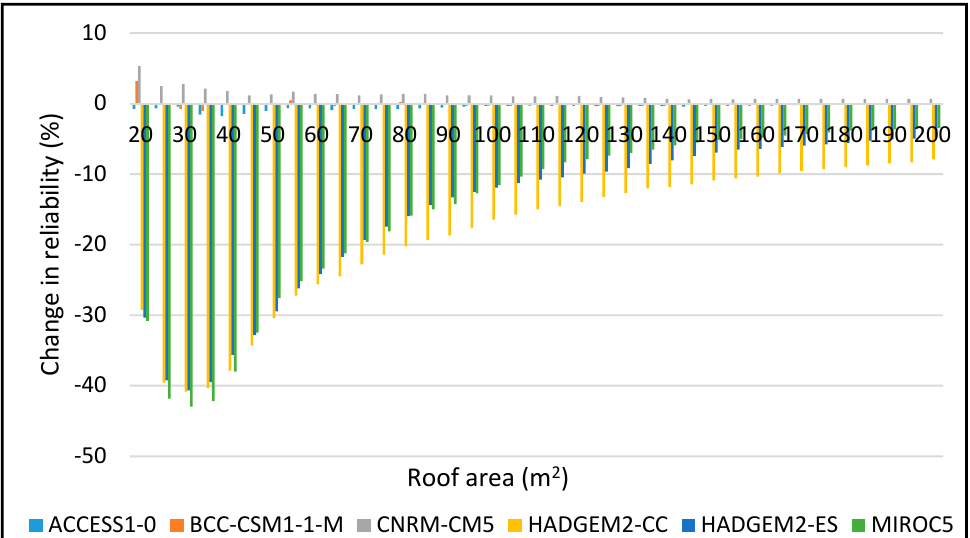
Figure 26. Change in reliability for MAM 2060–2090 period for 2 m 3 tank size.